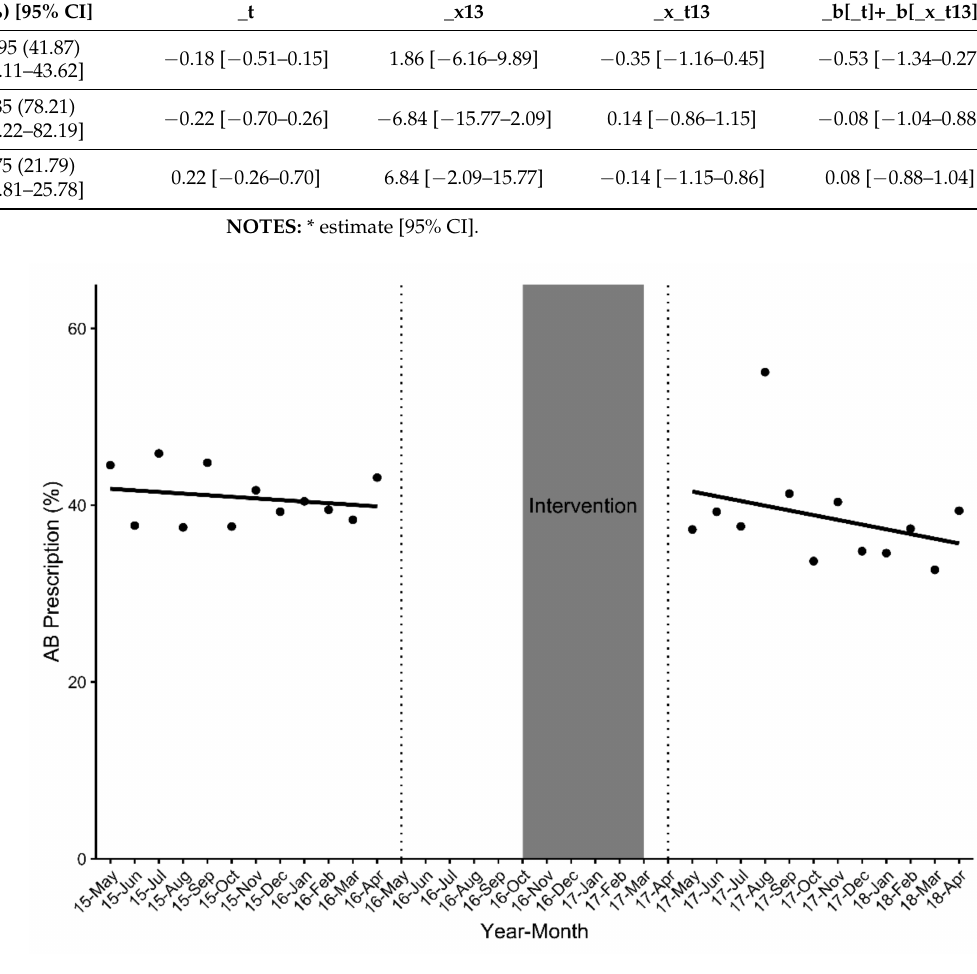
Figure 2. Change in the overall proportion of antibiotics prescribed (% AB prescription) to patients with acute respiratory tract complaints pre- and post-intervention ( n = 5455 eligible aRTC